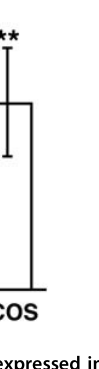
Figure 7. Cebpdis overexpressed in theca cells from PCOS patients. Quantitative real-time RT-PCR results examining Cebpd mRNA expres- sion in theca cells derived from four healthy women and four PCOS patients are shown. Expression levels were normalized by Gapdh values and the relative values are shown (a.u.=arbitrary units). The two- sample independent t -test, for which the values were transformed to their common logs, and the nonparametric Mann-Whitney test, both yielded a statistically significant difference at P ,